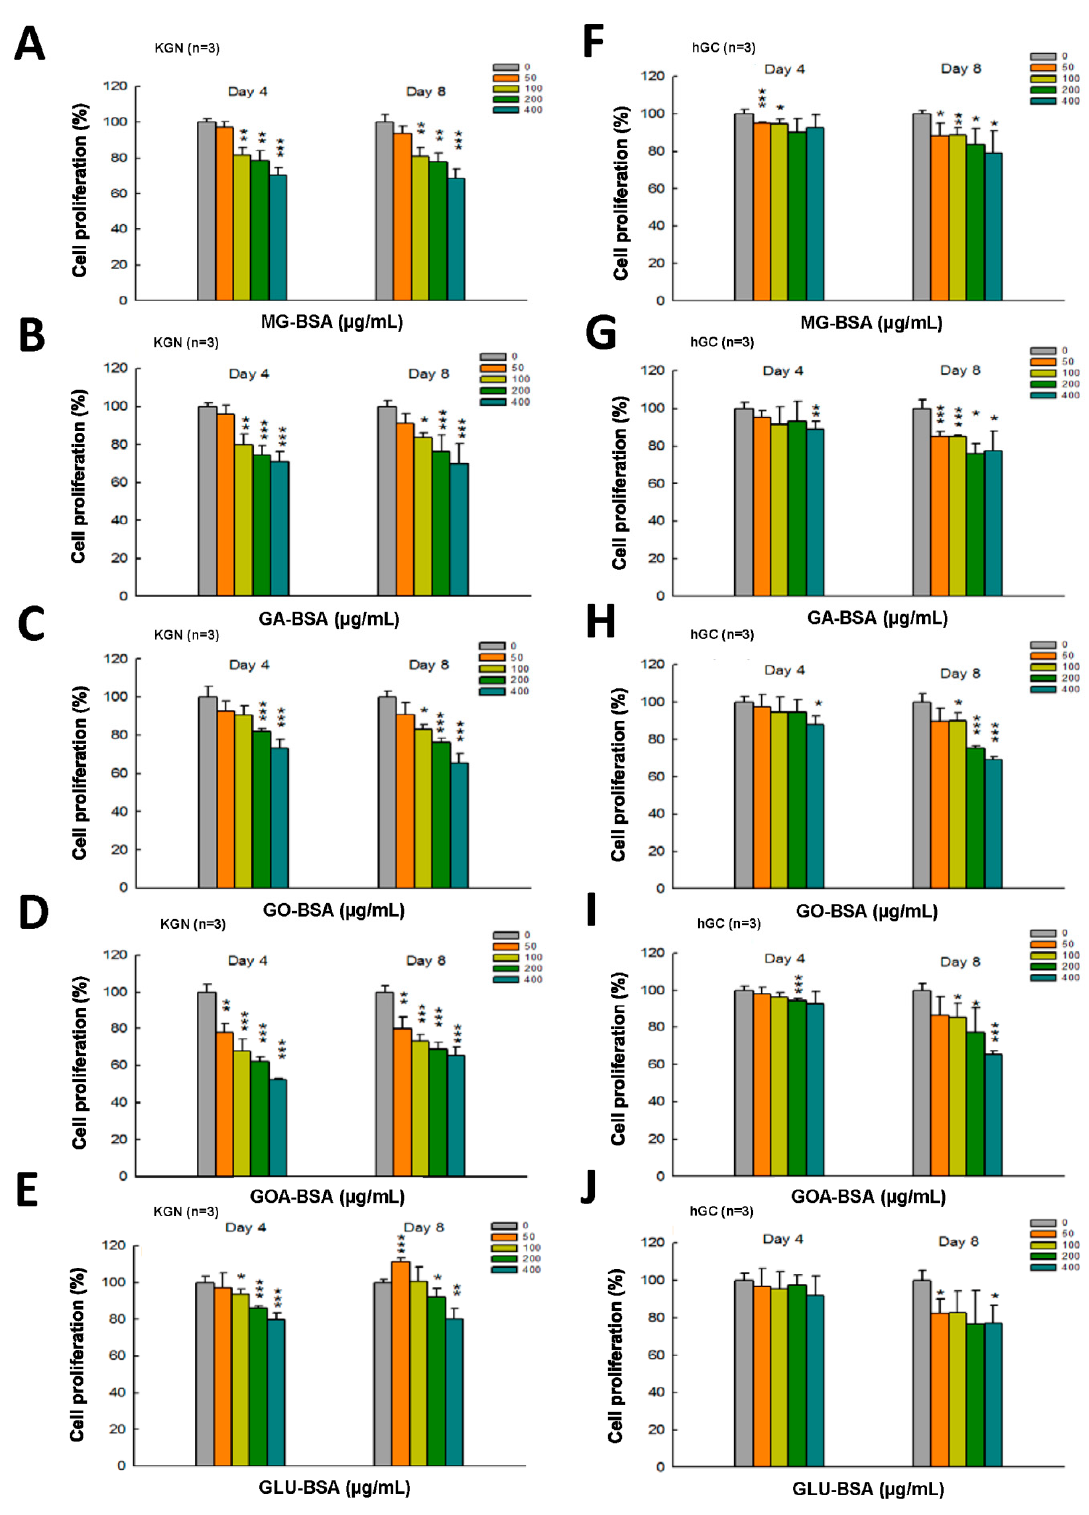
Figure 2. Dose–response assessment of AGE products in KGN and hGC cells. Both KGN and hGC cells were seeded into a 96-well plate (5 × 10 3 cells per well). After the cells attached on the bottom of the plate, they were then treated with BSA (400 µ g / mL) as a control and ( A , F ) MG-BSA, ( B , G ) GA-BSA, ( C , H ) GO-BSA, ( D , I ) GOA-BSA, and ( E,J ) GLU-BSA for four and eight days, respectively. Data are shown as the mean ± SD ( n = 3). * p < 0.05, ** p < 0.01, *** p < 0.001 compared with the control group.